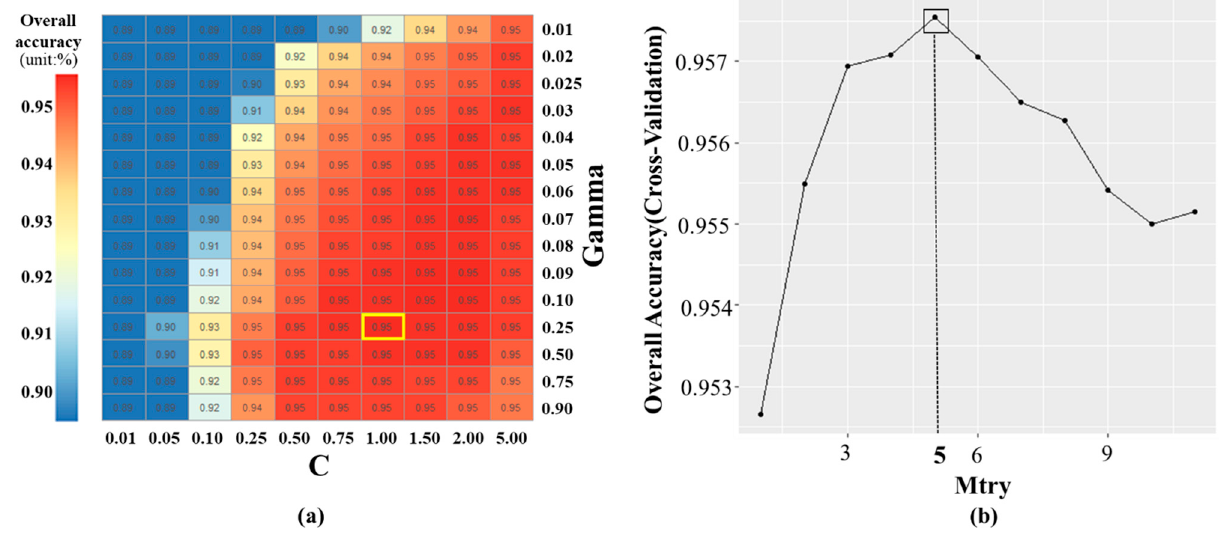
Figure 11. This figure shows the result of tuning hyperparameters using the preprocessed training dataset to utilize the SVM algorithm and RF algorithm. ( a ) A heat map for cross-validation of SVM hyperparameter C and Gamma, and ( b ) a grid search result for the mtry setting, a hyperparameter of RF.